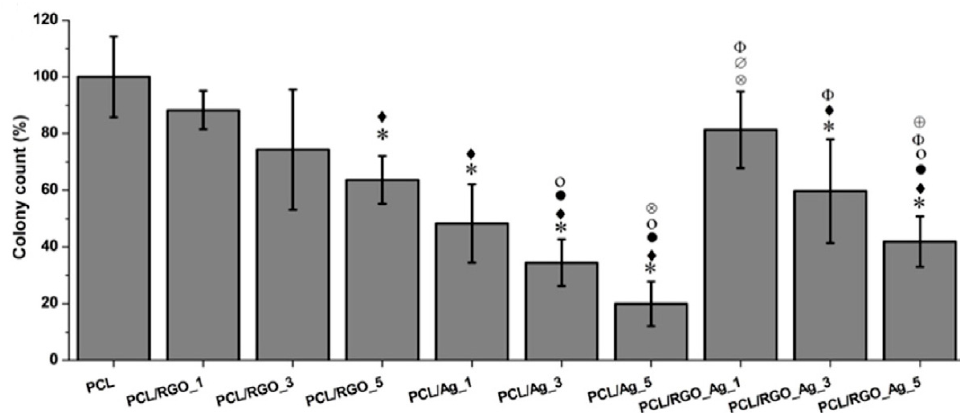
Figure 28. Colony count on composite surfaces incubated with E. coli for 3 h with respect to neat PCL. Statistically significant differences ( p < 0.05) compared to PCL, PCL/RGO_1, PCL/RGO_3, PCL/RGO_5, PCL/Ag_1 and PCL/Ag_3 and PCL/Ag_5, PCL/RGO_Ag_1 are indicated by *, ♦ , •, ο , ⊗ , ∅ , Φ and ⊕ , respectively. Reproduced with permission from [187], Copyright Elsevier, 2016.